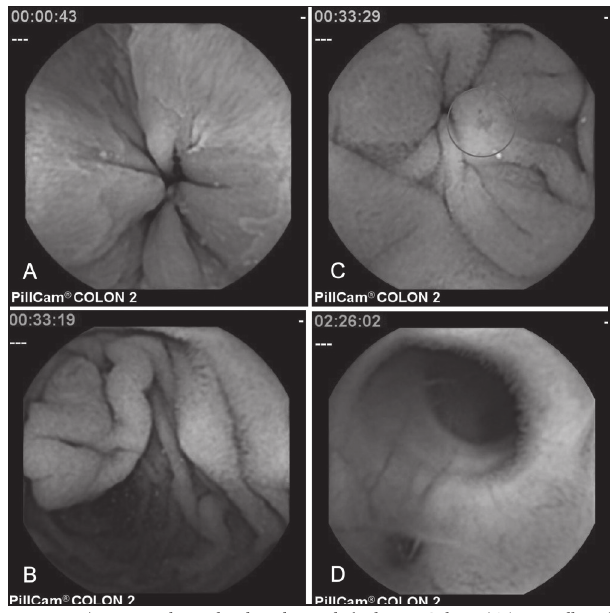
Figure 1) Different colonic pathologies found in capsule endoscopy. Two colorectal polyps measuring 17 mm ( A ) and 10 mm ( B ), an angiodysplasia ( C ) and a diverticulum ( D )